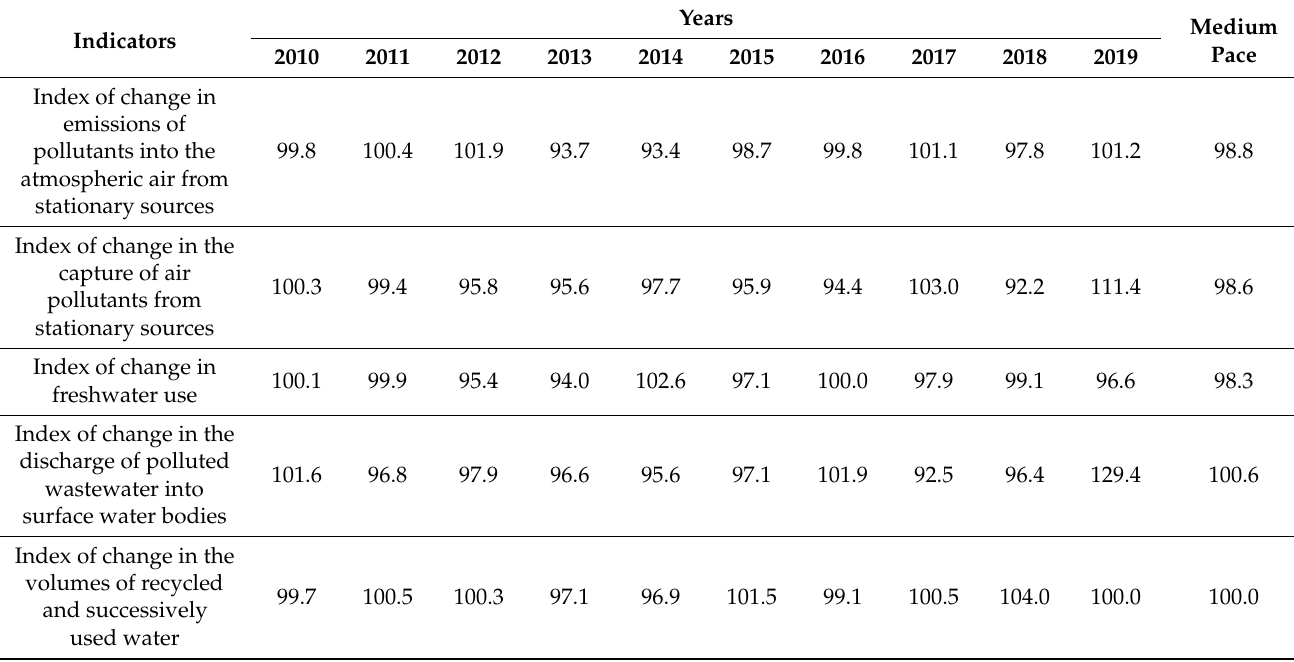
Table 8. Dynamics of changes in indicators characterizing the macro-regional block “Ecology” in the Russian Federation in 2010–2019, per capita in % of the previous